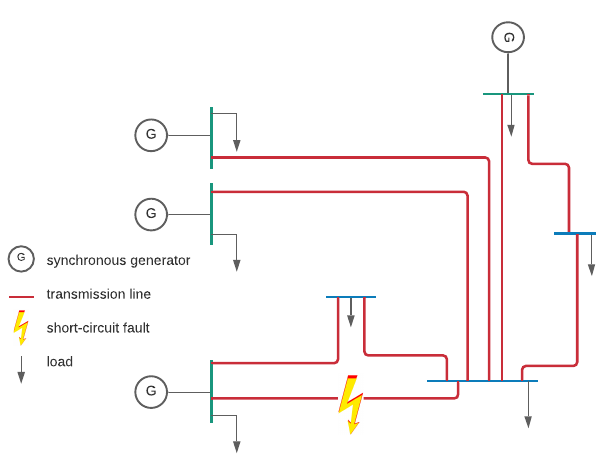
Figure 2. Simplified diagram of a four-machine power system.